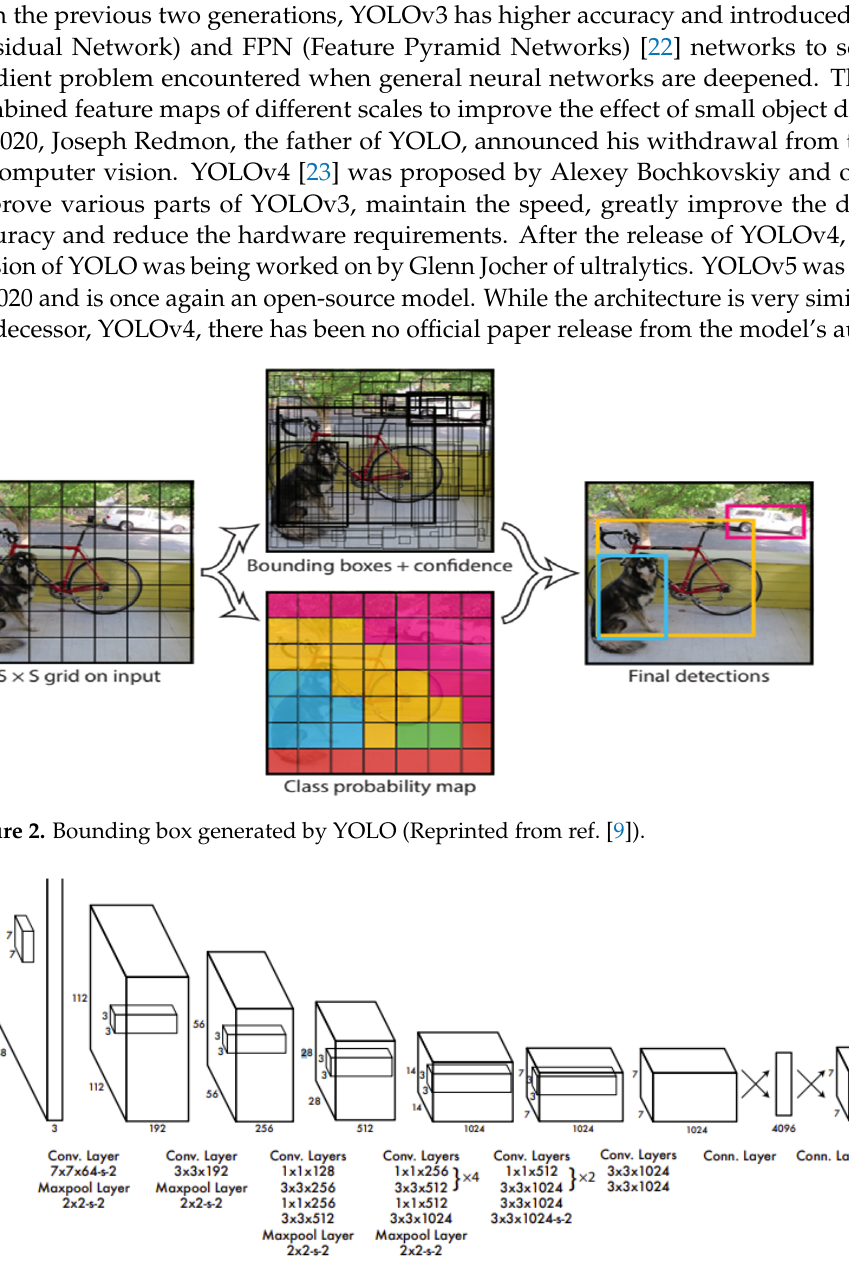
Figure 3. YOLO network architecture diagram (Reprinted from ref. [9]).